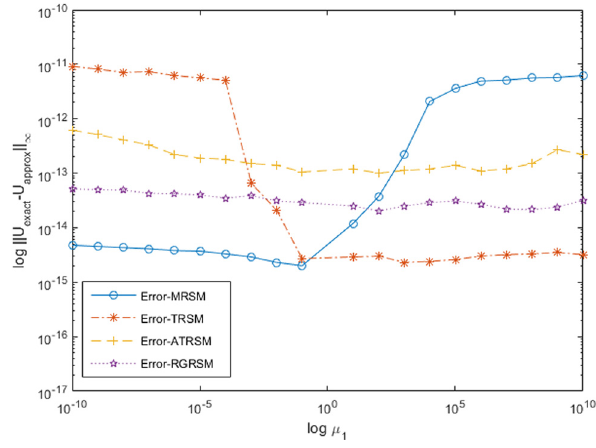
Figure 5: The absolute error of Example 4.1 for regularization para - meters when μ